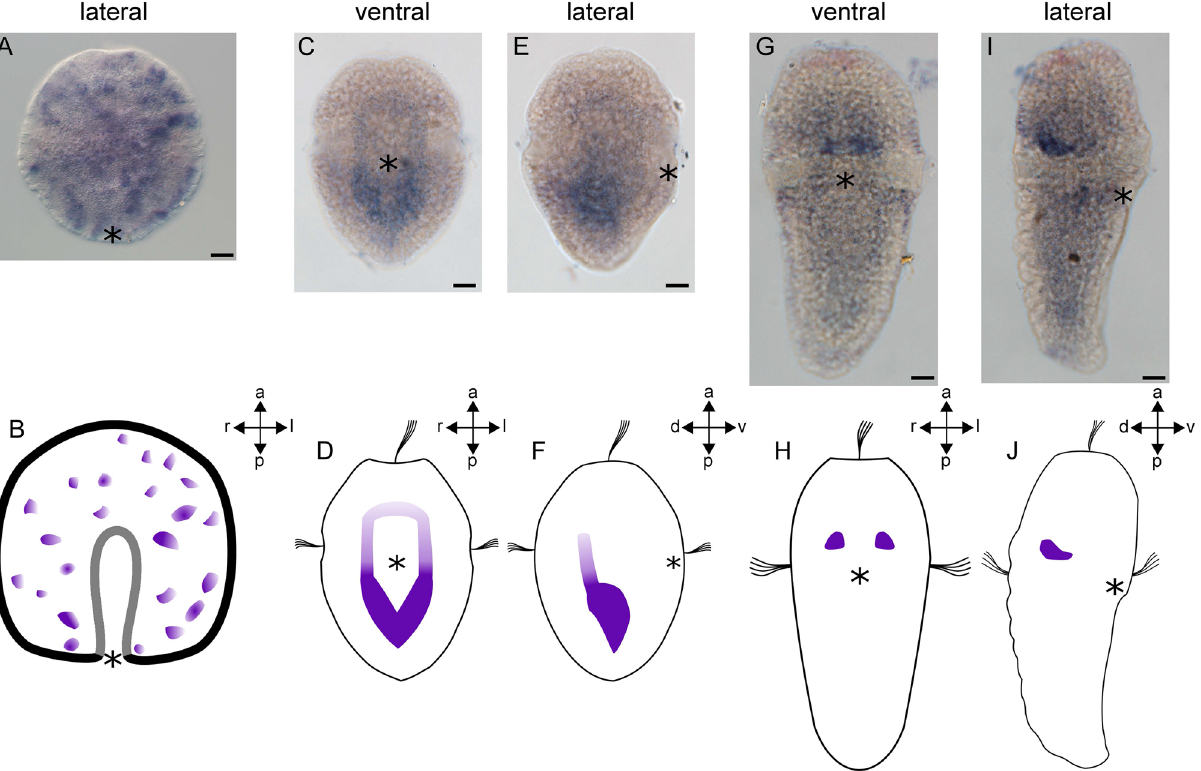
Figure 3. Expression of AfaHESC2 during early mesoderm formation in Acanthochitona fascicularis . ( B , D , F , H , J ) are schematic representations of gene expression signatures (in purple) of the respective developmental stages. ( A , B ) Expression of AfaHESC2 in the gastrula. ( A ) AfaHESC2 is expressed in ectodermal cells of the gastrula. ( B ) Lateral view ( C – F ) AfaHESC2 expression in the early trochophore larva. ( C ) AfaHESC2 is expressed in the mesodermal bands. A weak expression domain extends into the larval episphere. ( D ) Ventral view. ( E ) Lateral right view of AfaHESC2 expression in the early trochophore larva. A weak expression domain extends into the larval episphere. ( F ) Lateral right view. ( G – J ) AfaHESC2 expression in the late trochophore larva. ( G ) AfaHESC2 is expressed in two spot-like domains in the region of the adult buccal ganglia. ( H ) Ventral view. ( I ) Lateral view of AfaHESC2 expression showing that the spot-like expression domains are located dorsally. ( J ) Lateral view. Asterisks mark the blastopore and the mouth, respectively. a anterior, d dorsal, l left, p posterior, r right, v ventral. Scale bar equals 20 µm. Expression pattern schemes were designed with Inkscape (version 0.92.4; https:// inksc ape. org) and Gimp 2 (Version 2.8.22; https:// www. gimp.